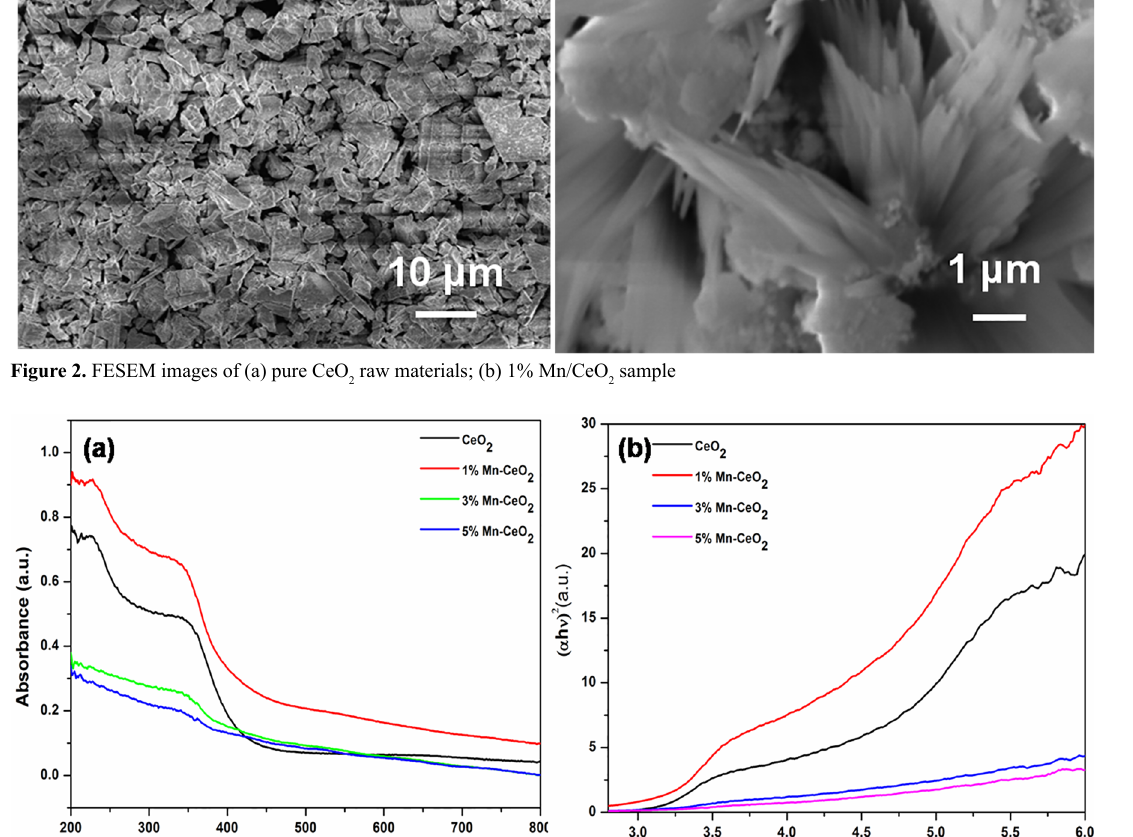
Figure 3. (a) UV-Vis absorption spectra of Mn/CeO and Mn-doped CeO 2